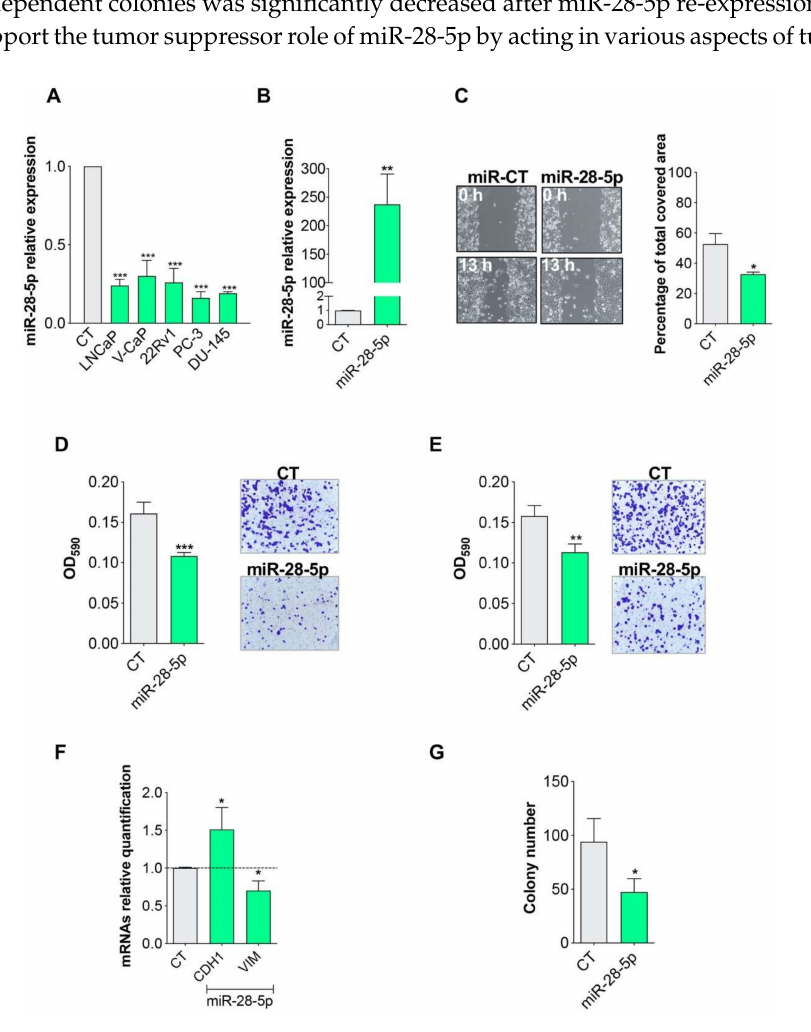
Figure 1. E ff ect of miR-28-5p re-expression in PCa cells. ( A ) Analysis of the miR-28-5p expression level by qRT-PCR in prostate cancer cell lines with respect to the normal cells RNA. ( B ) Relative expression level of miR-28-5p, evaluated by qRT-PCR, after miR-28-5p transfection in DU-145 cells. Cell migration ( C , D ) and invasion ( E ) of DU-145 cells after miR-28-5p overexpression evaluated by wound healing assay ( C ) and trans-well assay ( D , E ). ( F ) Relative expression of E-cadherin 1 (CDH1) and vimentin (VIM) in miR-28-5p overexpressing versus normal DU-145 cells. ( G ) Number of colonies formed in soft agar in DU-145 cells after miR-28-5p or CT overexpression. * p < 0.05, ** p < 0.01, *** p < 0.001, unpaired t